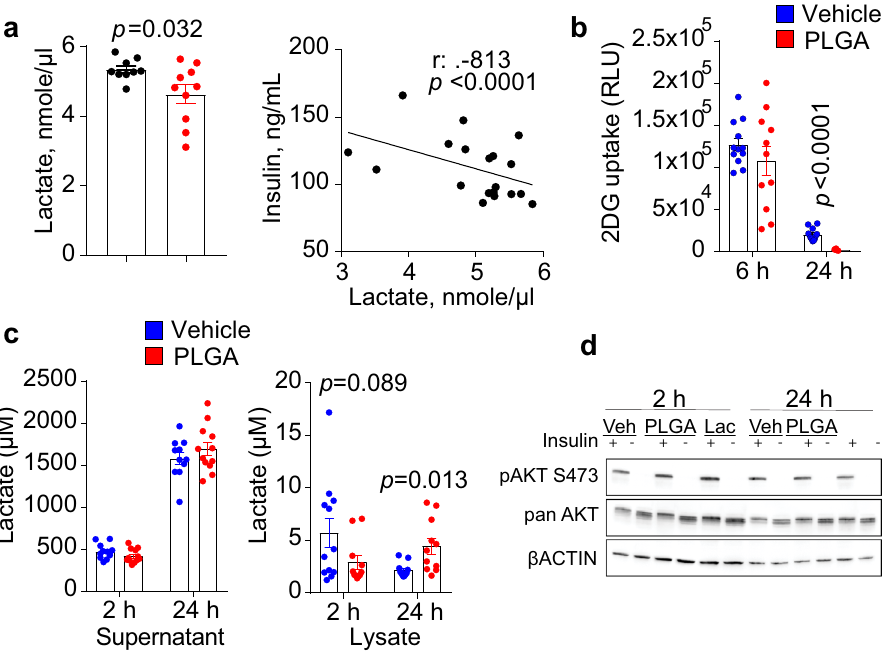
Figure 2. PLGA alters intracellular glucose uptake and lowers lactate levels. ( a ) Administration of PLGA nanoparticles for 2 weeks significantly lowered plasma lactate levels ( t-value : 2.435; degrees of freedom : 11.528) (n = 10 mice/group). Furthermore, plasma lactate was negatively correlated with plasma insulin levels; ( b ) 2-deoxy-D-( +)-glucose (2DG) uptake in L6 myotube cells was significantly lower after 24 h treatment with PLGA (1 mg/mL) ( t-value : 8.359; degrees of freedom : 13.698) (n = 12 replicates/group); ( c ) Lactate concentrations in supernatants and lysates of L6 myotubes were significantly higher in cell lysates after 24 h treatment with PLGA (1 mg/mL) ( t-value : − 2.942; degrees of freedom : 11.476) (n = 12 replicates/group); ( d ) Insulin signaling experiments in L6 myotubes treated with 1 mg/mL PLGA, 50 mM lactate (Lac) or vehicle control (veh) showed no difference in levels of phosphorylated AKT in response to 100 nM insulin for 5 min. Representative images of phosphorylation on AKT residue Ser 473 and loading controls, pan AKT and βACTIN are shown. Uncropped blot images are presented in supplementary files. Independent t -test was used when comparing two groups and correlation was determined by Spearman’s rank correlation analysis, p <